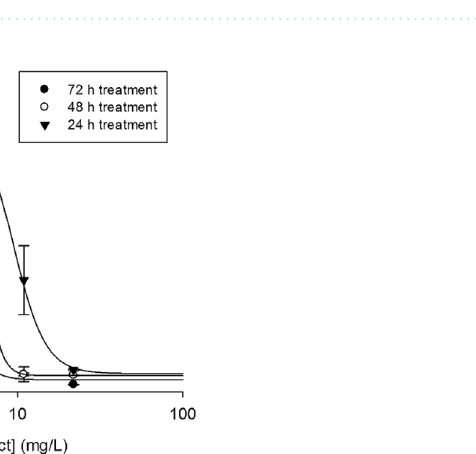
Figure 1. HPLC–MS chromatogram of the A. heterophyllus Lam. extract containing artocarpin (inset).